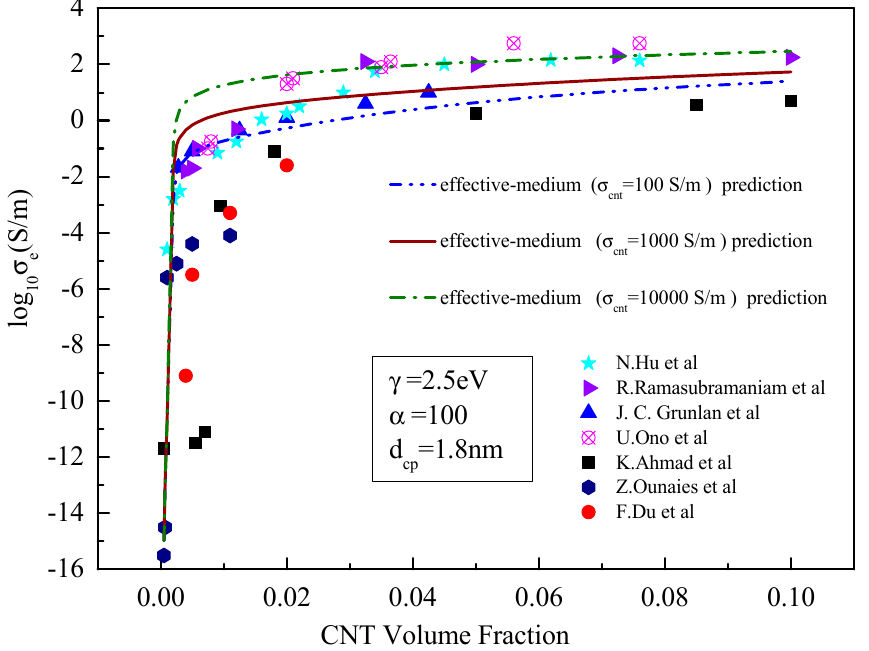
Figure 4. Comparison between the prediction results of the effective medium model and existing experimental data [21,23–28] with different conductivity of the CNT.